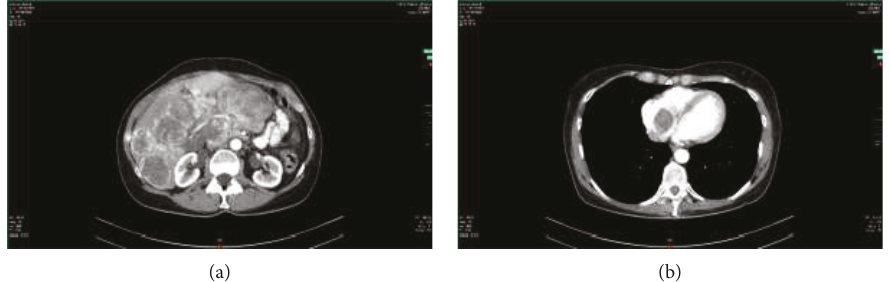
Figure 2: (a) Abdominal CT scan with IV contrast showing multiple liver metastases. (b) Chest CT scan showing a fi lling defect within the contrast-enhanced right atrium which was initially thought to be a large